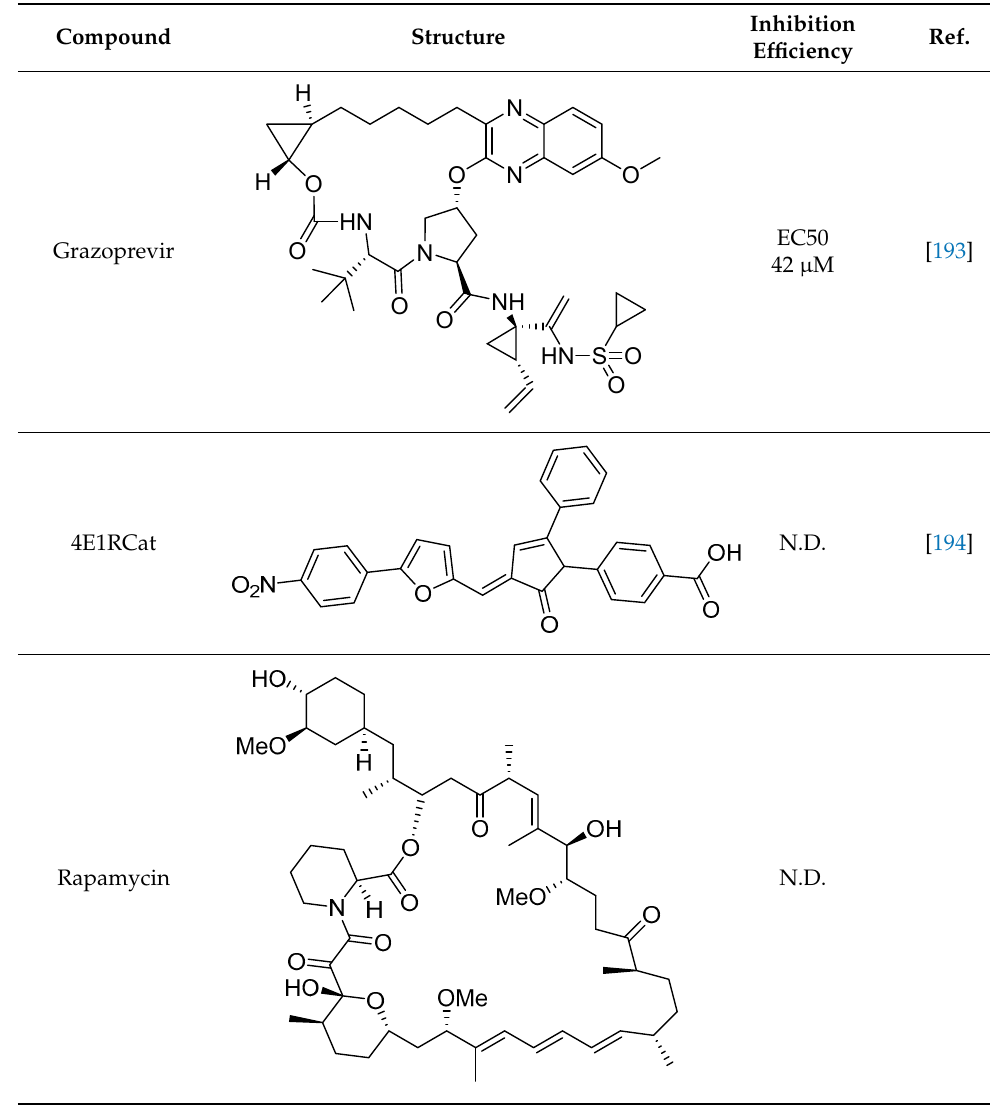
Inhibition Efficiency